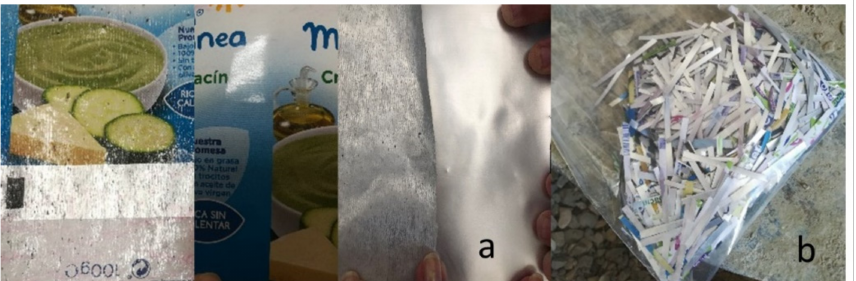
Figure 1. Plastic sheets from food packaging: front and back sides ( a ) and the prepared fibres ( b ). The tested plastic sheets were made of four overlapping layers of different materials: polyester, aluminium, bi-axially oriented polyamide that is resistant to thermal sterilisation treatment (121 ◦ C for 30 min), and polypropylene (PET + ALU + OPA STE + PP G).